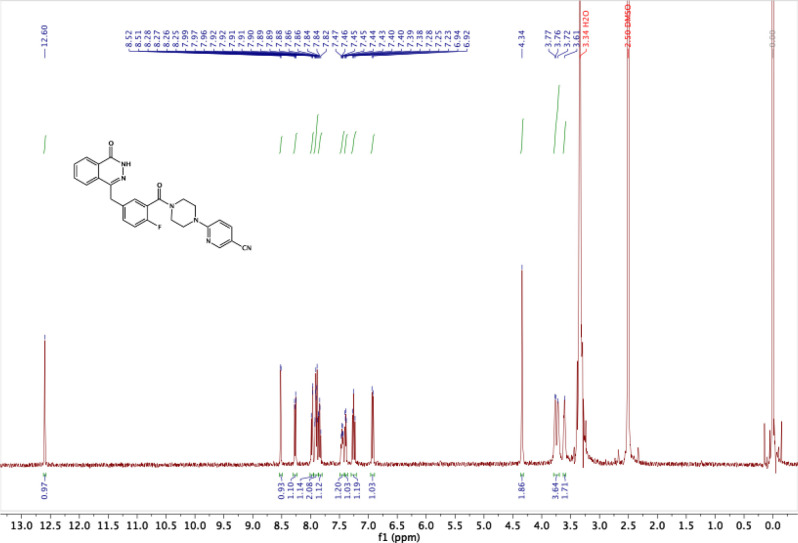
1H NMR of Phthal01.